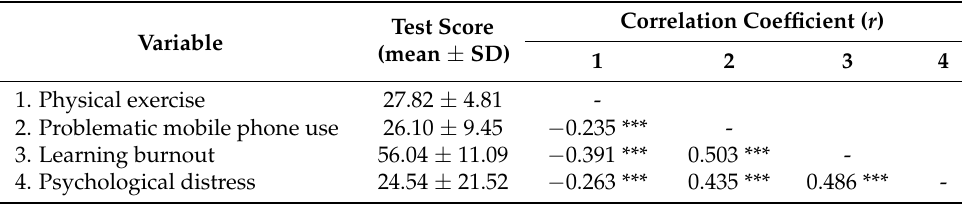
Table 2. Partial correlation analysis results for each variable.